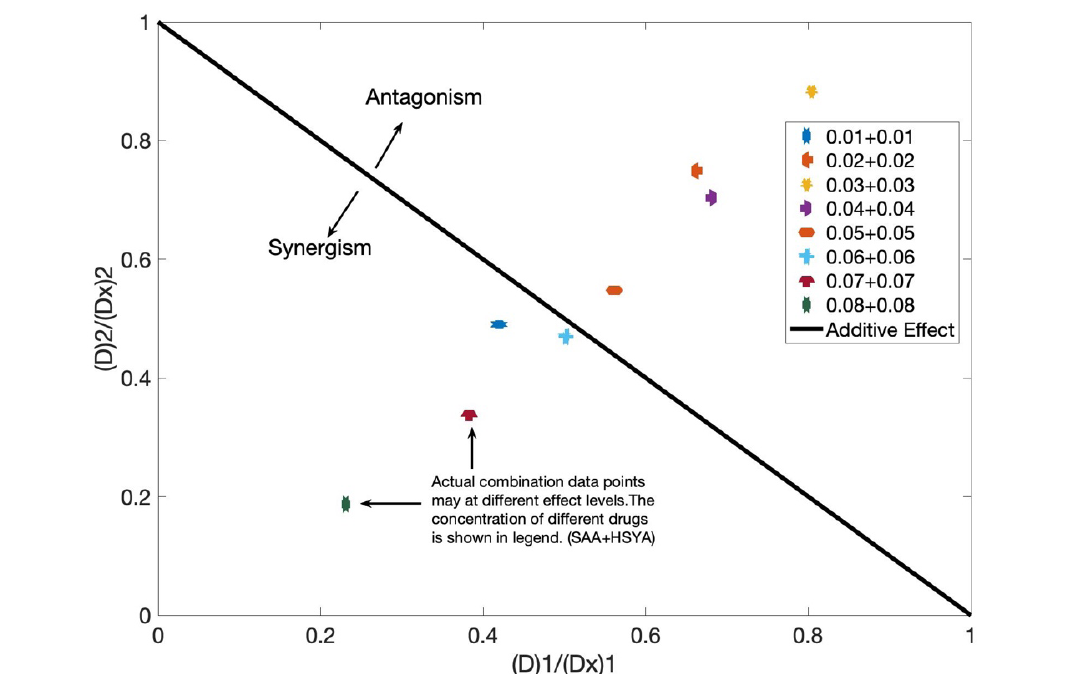
FIGURE 6 - The normalized isobologram figure when the ratio of SAA and HSYA is